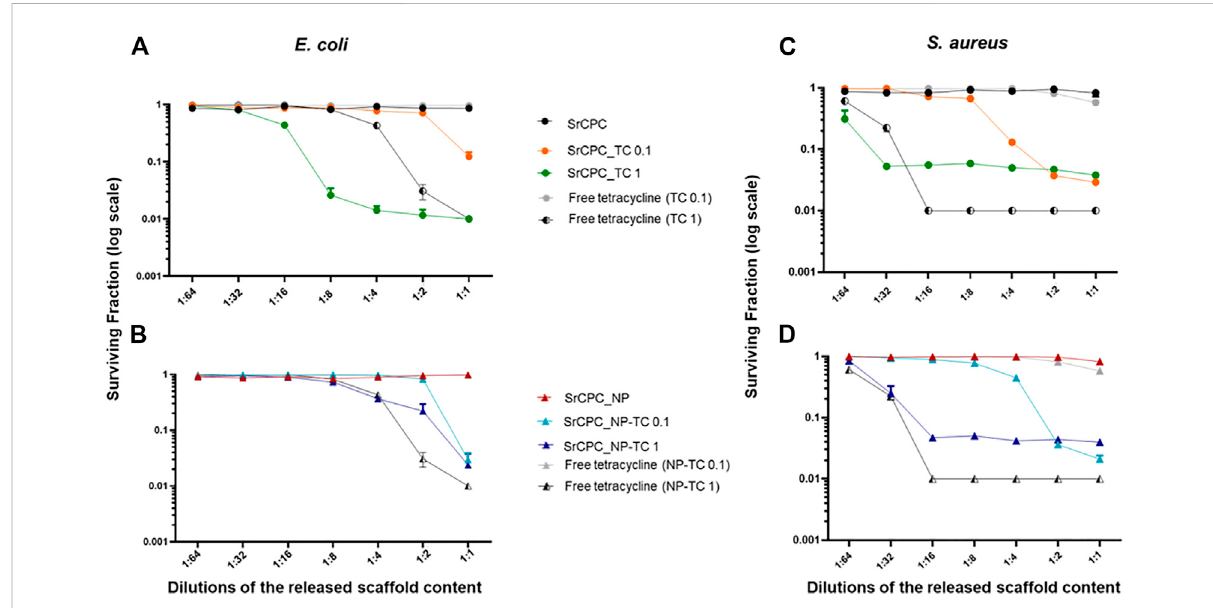
FIGURE 7 Bacterial viability of planktonic cultures by indirect contact. Each SrCPC_TC (A – C) and SrCPC_NP-TC (B – D) scaffolds, with their respective undopedsamples(SrCPC,SrCPC_NP),wereincubatedwithLBmedium,for24 hat37 ° C.Tetracycline-HClpowder(indicatedasfreetetracycline0.1; 1)was dissolved inLBaccording to the same concentrations released fromSrCPC_TC and SrCPC_NP-TC scaffoldsafter 24 h at37 ° C.The overnight solutions containing ions and antibiotics were diluted and incubated with planktonic E. coli (A,B) and S. aureus (C,D) cells for 24 h at 37 ° C, respectively. The data (log scale) were represented as the surviving fraction in respect to the control which is represented by bacteria grown in LB medium: p ≤ 0.05 (data not